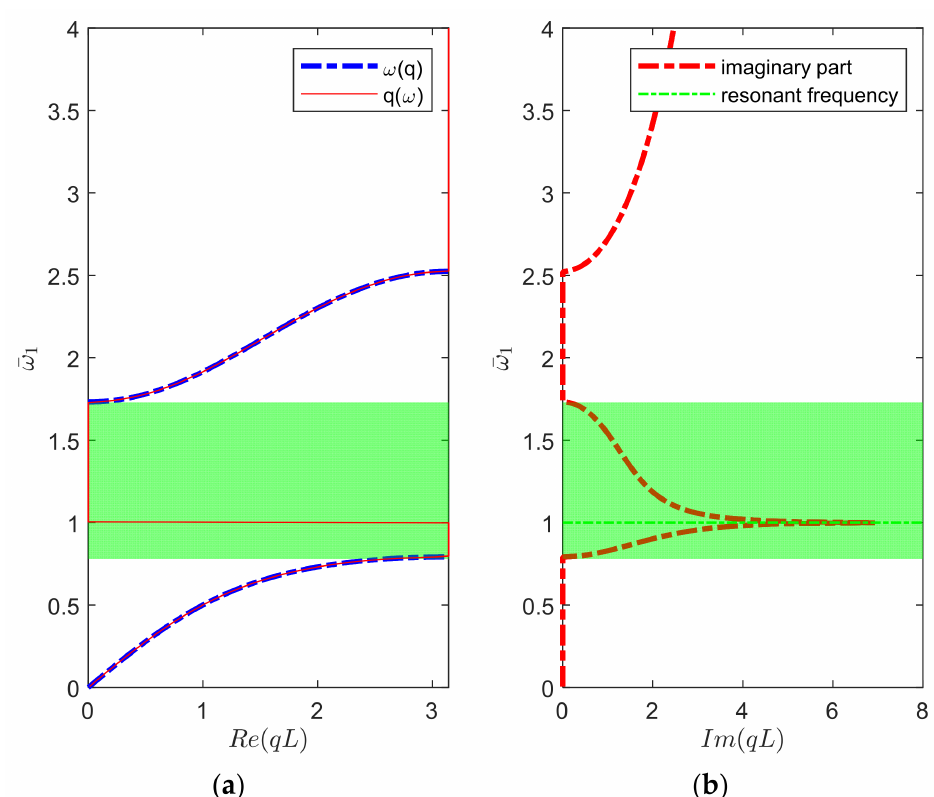
Figure 2. Band structure for a linear mass-in-mass lattice system with parameter ratios m 1 / m 0 = 2 and k 1 / k 0 = 2. ( a ) Dispersion relations solved by the ω ( q ) method and the real part solved by the q ( ω ) method. ( b ) Imaginary part of the dispersion relation solved by the q ( ω ) method with the local resonance frequency marked in light